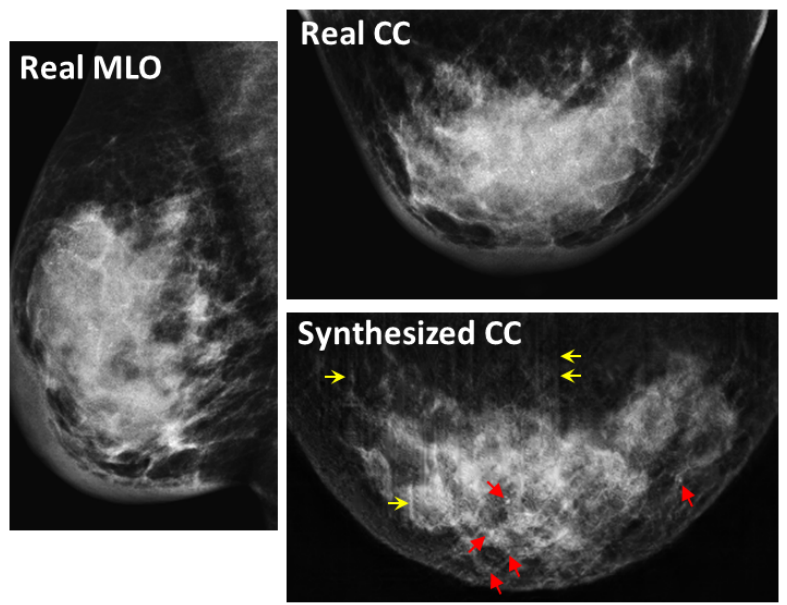
Figure 14. Enlarged views of Figure 13e. The red arrows indicate specks corresponding to calcifica- tions. The yellow arrows indicate stripe artifacts.